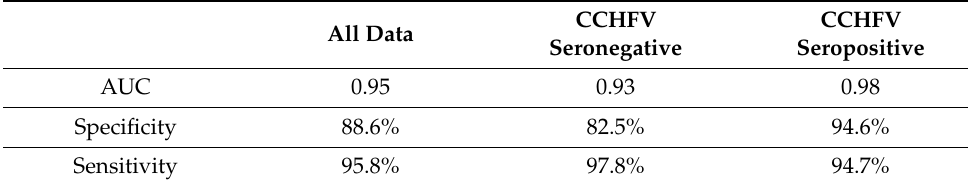
Table 3. Comparative ROC analysis.